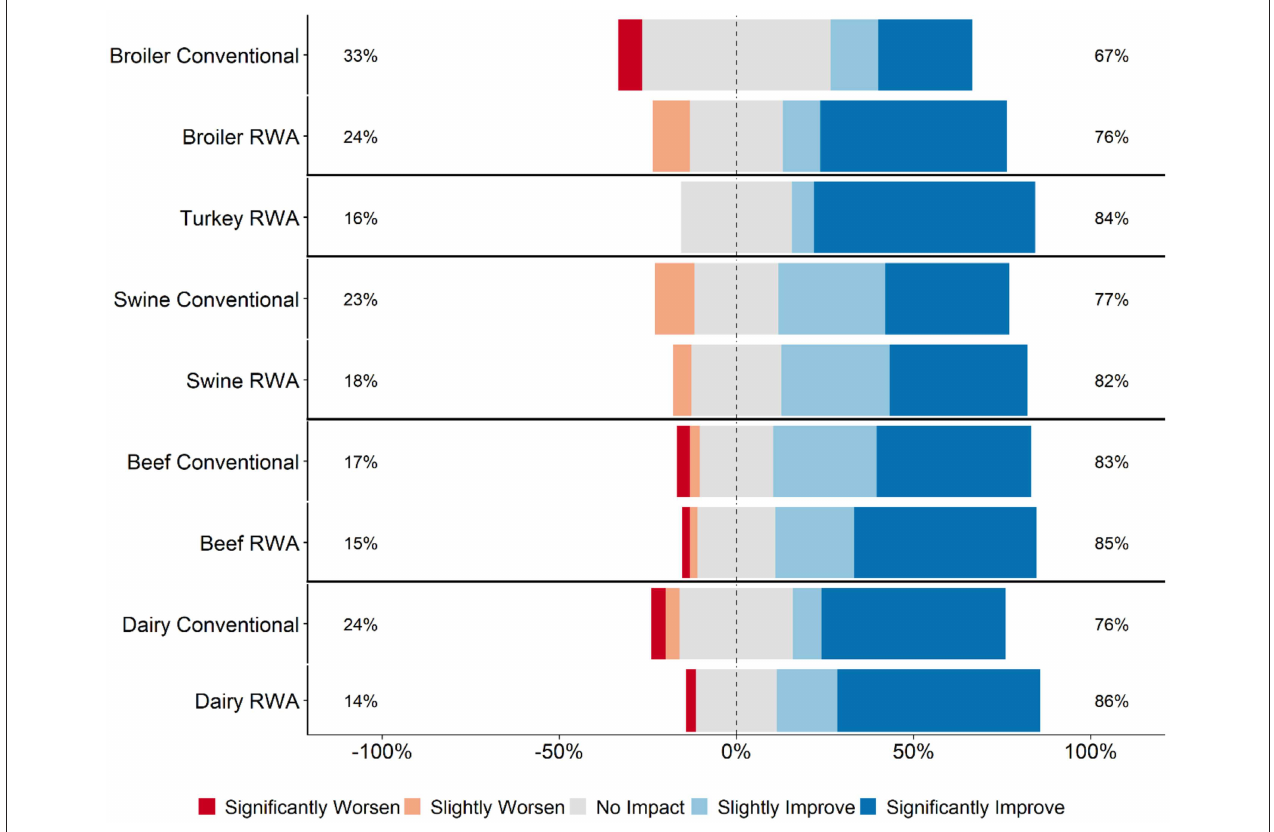
FIGURE 2 | Respondents’ opinion about customer perception regarding the impact of RWA production on animal health and welfare. Five-item Likert scale reporting respondents’ opinion, stratified by commodity and RWA experience.